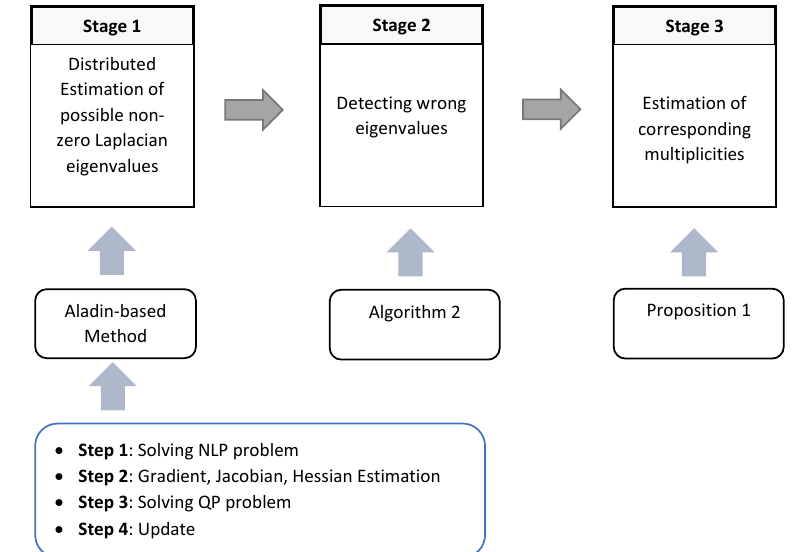
Figure 1. Structure of Section